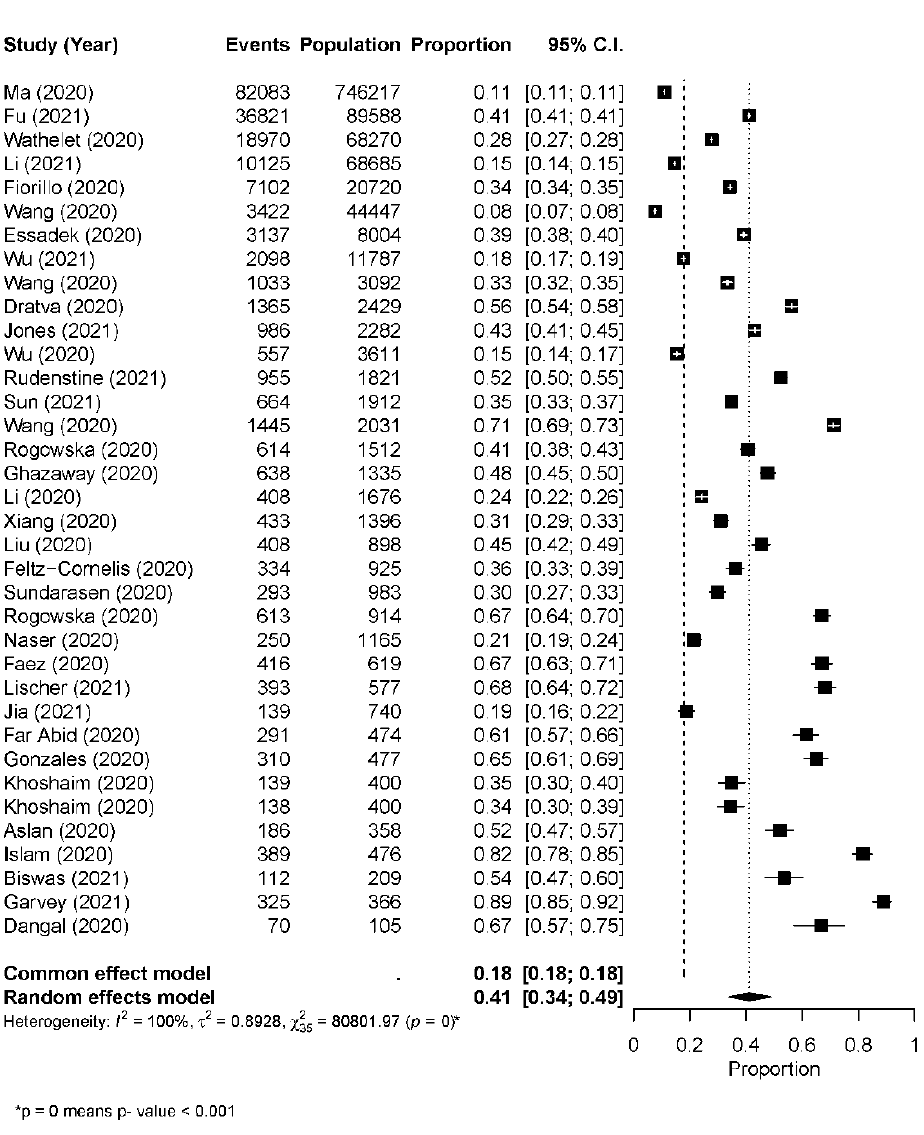
Figure 2. Forest plot of the prevalence of anxiety (all studies).